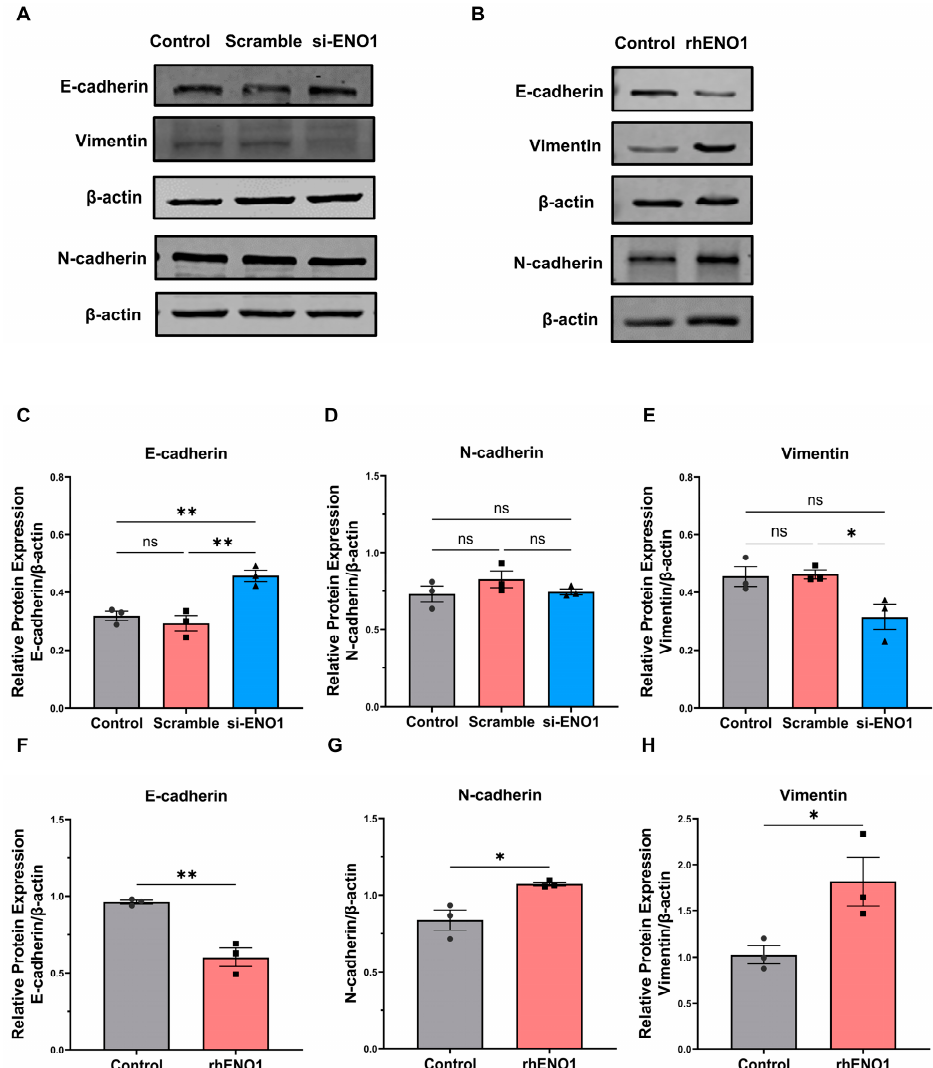
Figure 3. ENO1 promotes epithelial–mesenchymal transition of tumor cells through macrophages. ( A ) Western blot representative image of E-cadherin, Vimentin and N-cadherin relative protein levels in CAL27 cells incubated with Macro-CM from macrophages induced by untreated (control), scrambled siRNA and ENO1-siRNA-transfected tumor supernatant, respectively, for 48 h. ( B ) Western blot representative image of E-cadherin, Vimentin and N-cadherin relative protein levels in CAL27 cells cocultured with Macro-CM from macrophage-induced tumor supernatant without or with rhENO1 for 48 h. ( C – H ) Statistical analysis of Western blot. Different symbols (circle/square/triangle) were used to represent the data points of independent biological repeated experiments. All data are displayed as mean ± SEM; n = 3; ns, no significance, * p < 0.05 and ** p < 0.01.